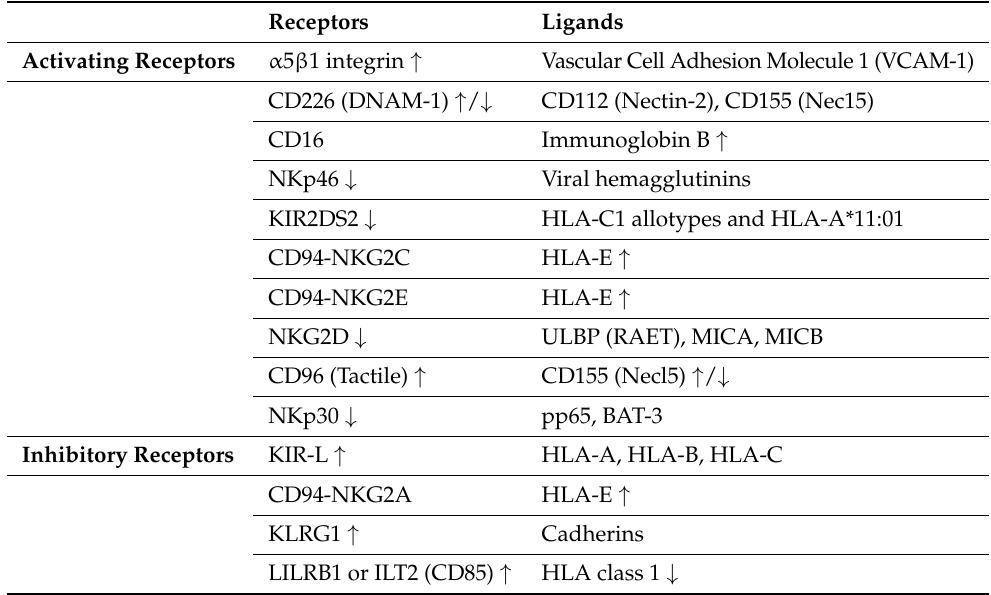
Table 1. Alteration of different NK cells receptors and ligands in uterine or endometrial cancer patients. Arrows indicate the increase or decrease in their expression or